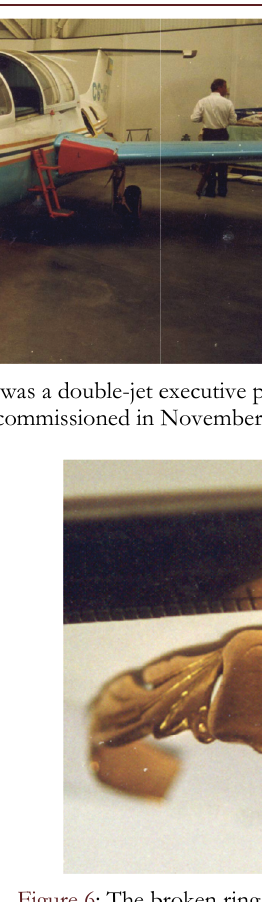
Figure 5: Cockp right front William M